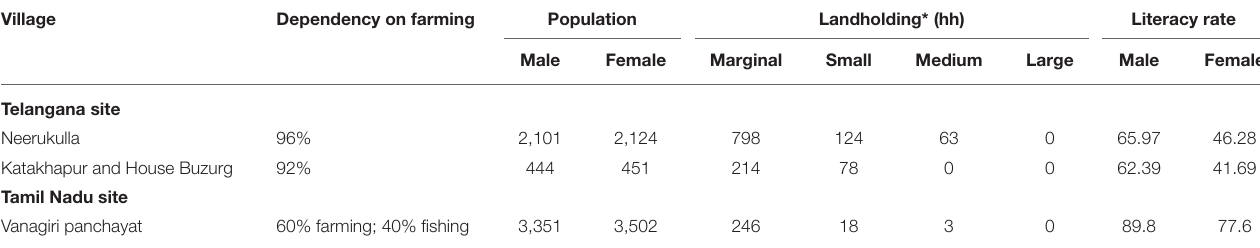
TABLE 1 | Characteristics of study villages.